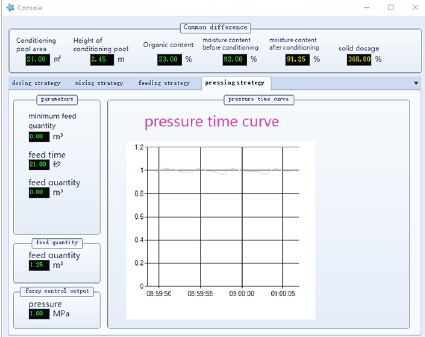
Figure 7: Press interface and time pressure